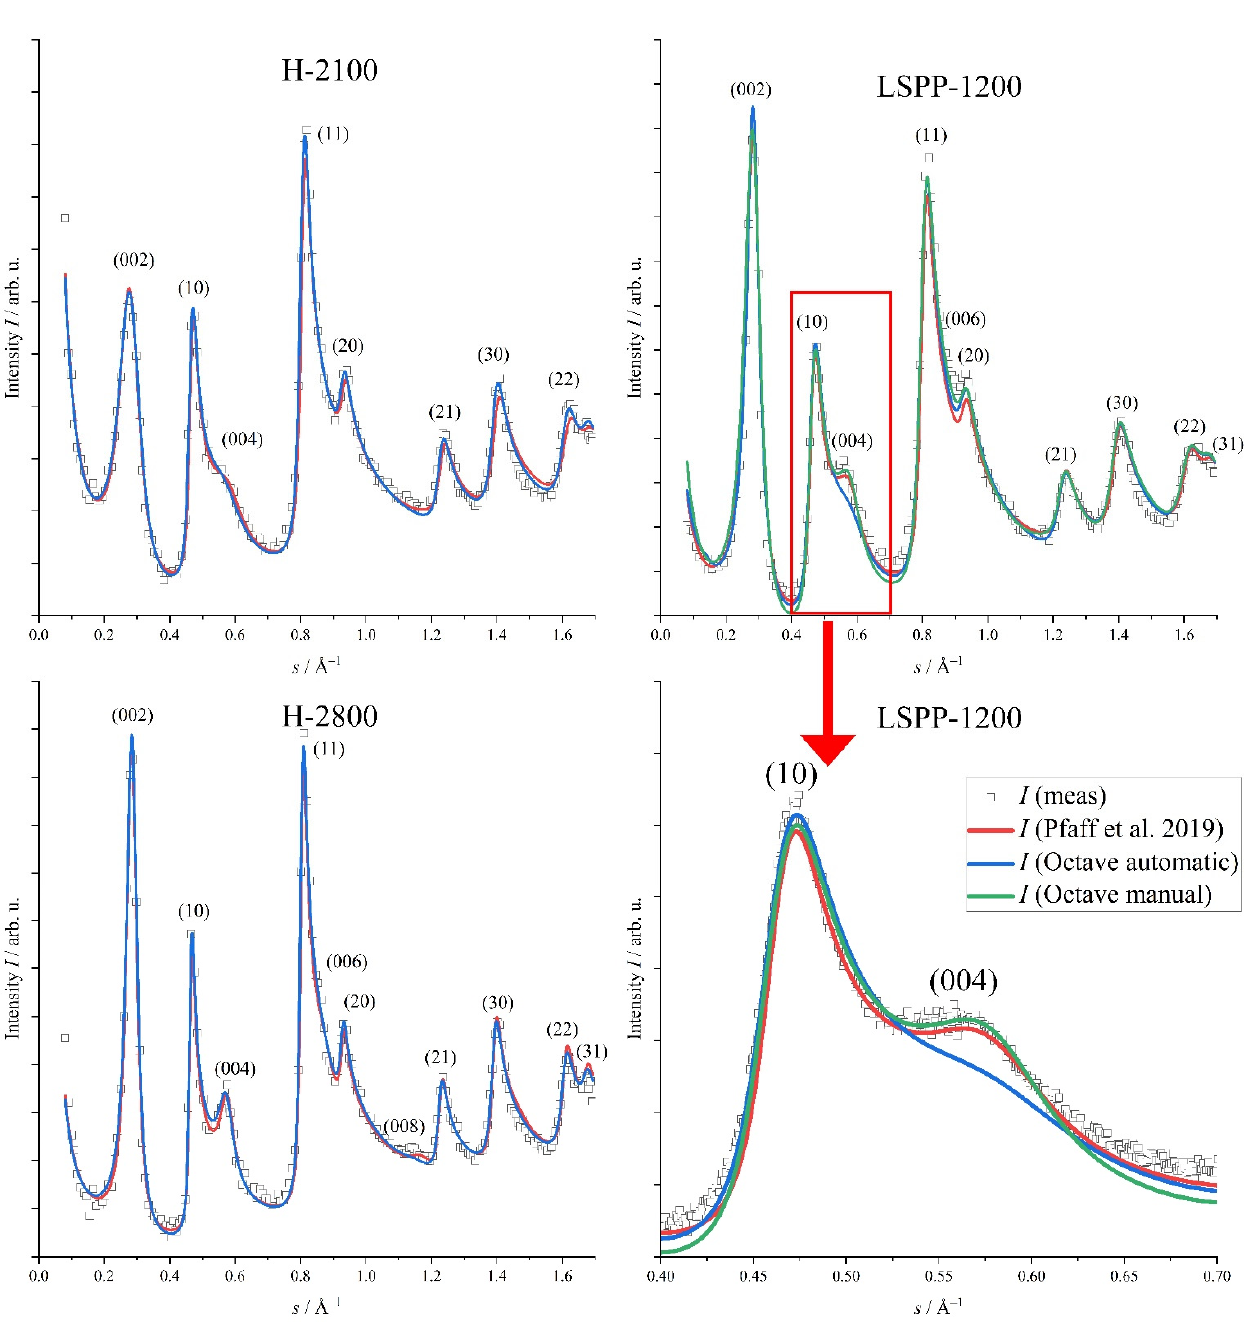
Figure 7. Refinement of previously reported wide-angle neutron scattering (WANS) data by Pfaff et al. [26]. The measured WANS data (black; every 10th point (except for the last plot)) were fitted automatically (red) and the result manually refined (blue). For H-2800, no manual refinement was needed. For LSPP-1200, the interlayer parameters had to be adjusted to fit better the (004) reflection.